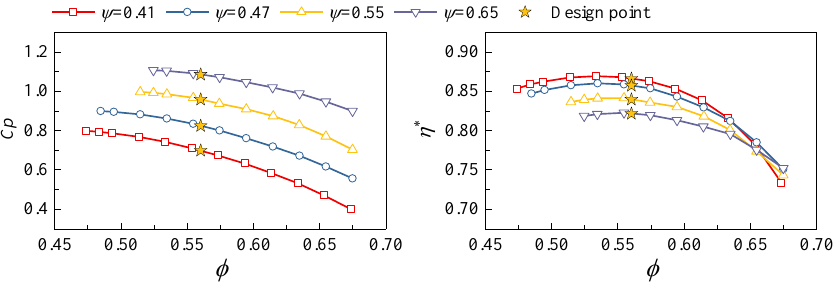
Figure 11. Stage pressure-rise coefficient and efficiency.